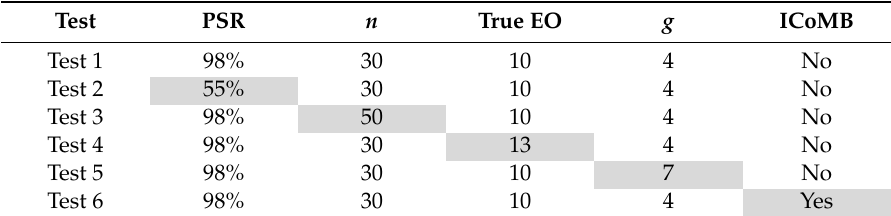
Table 2. The simulated